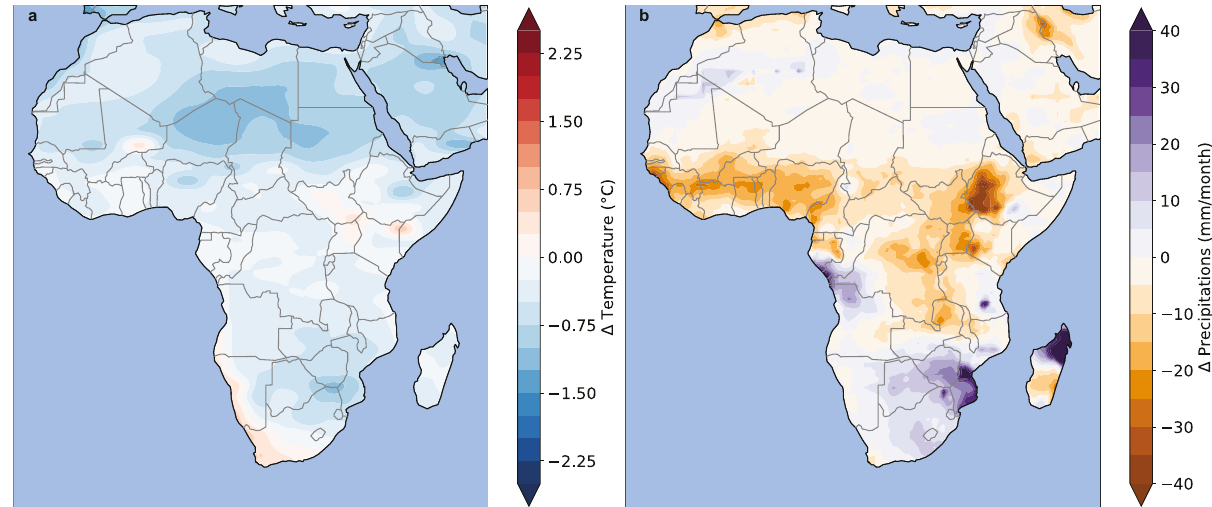
Fig. 4 Impacts of an additional ice-melting on climate parameters. a Temperature (° C ) and ( b ) rainfall (mm.month − 1 ) difference between the ICE1m and RCP8.5 simulation for the 2040s.